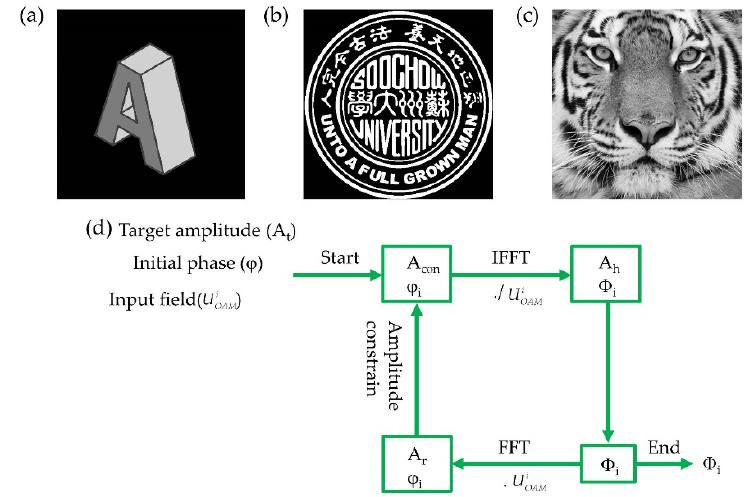
Figure 3. ( a ) Grayscale image of the letter “A”; ( b ) logo of Soochow University in pure white and black pixels, which includes the name and motto of the University in English and Chinese; ( c ) grayscale image of a tiger with finer details; ( d ) flow chart of WGS algorithm.